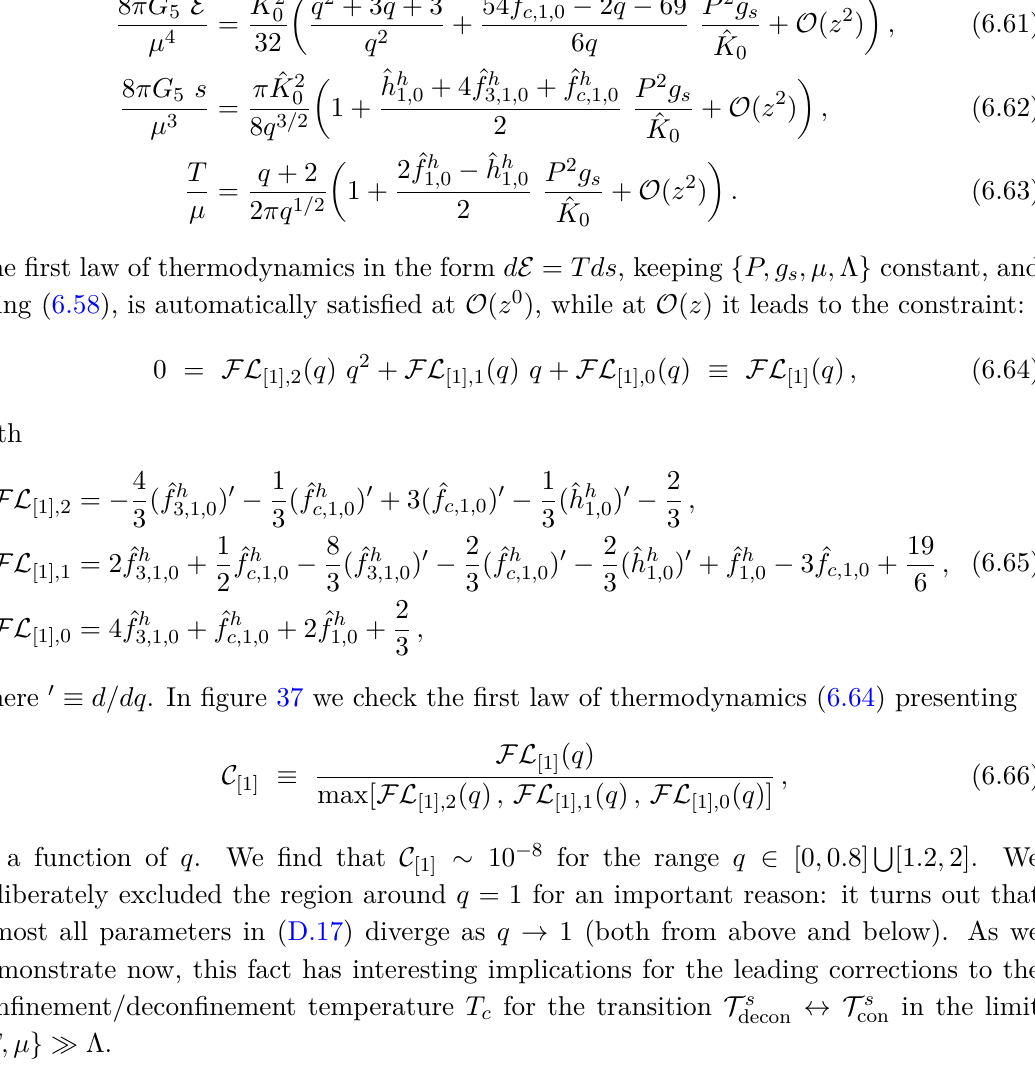
− 1 (the right panel) as 2 C